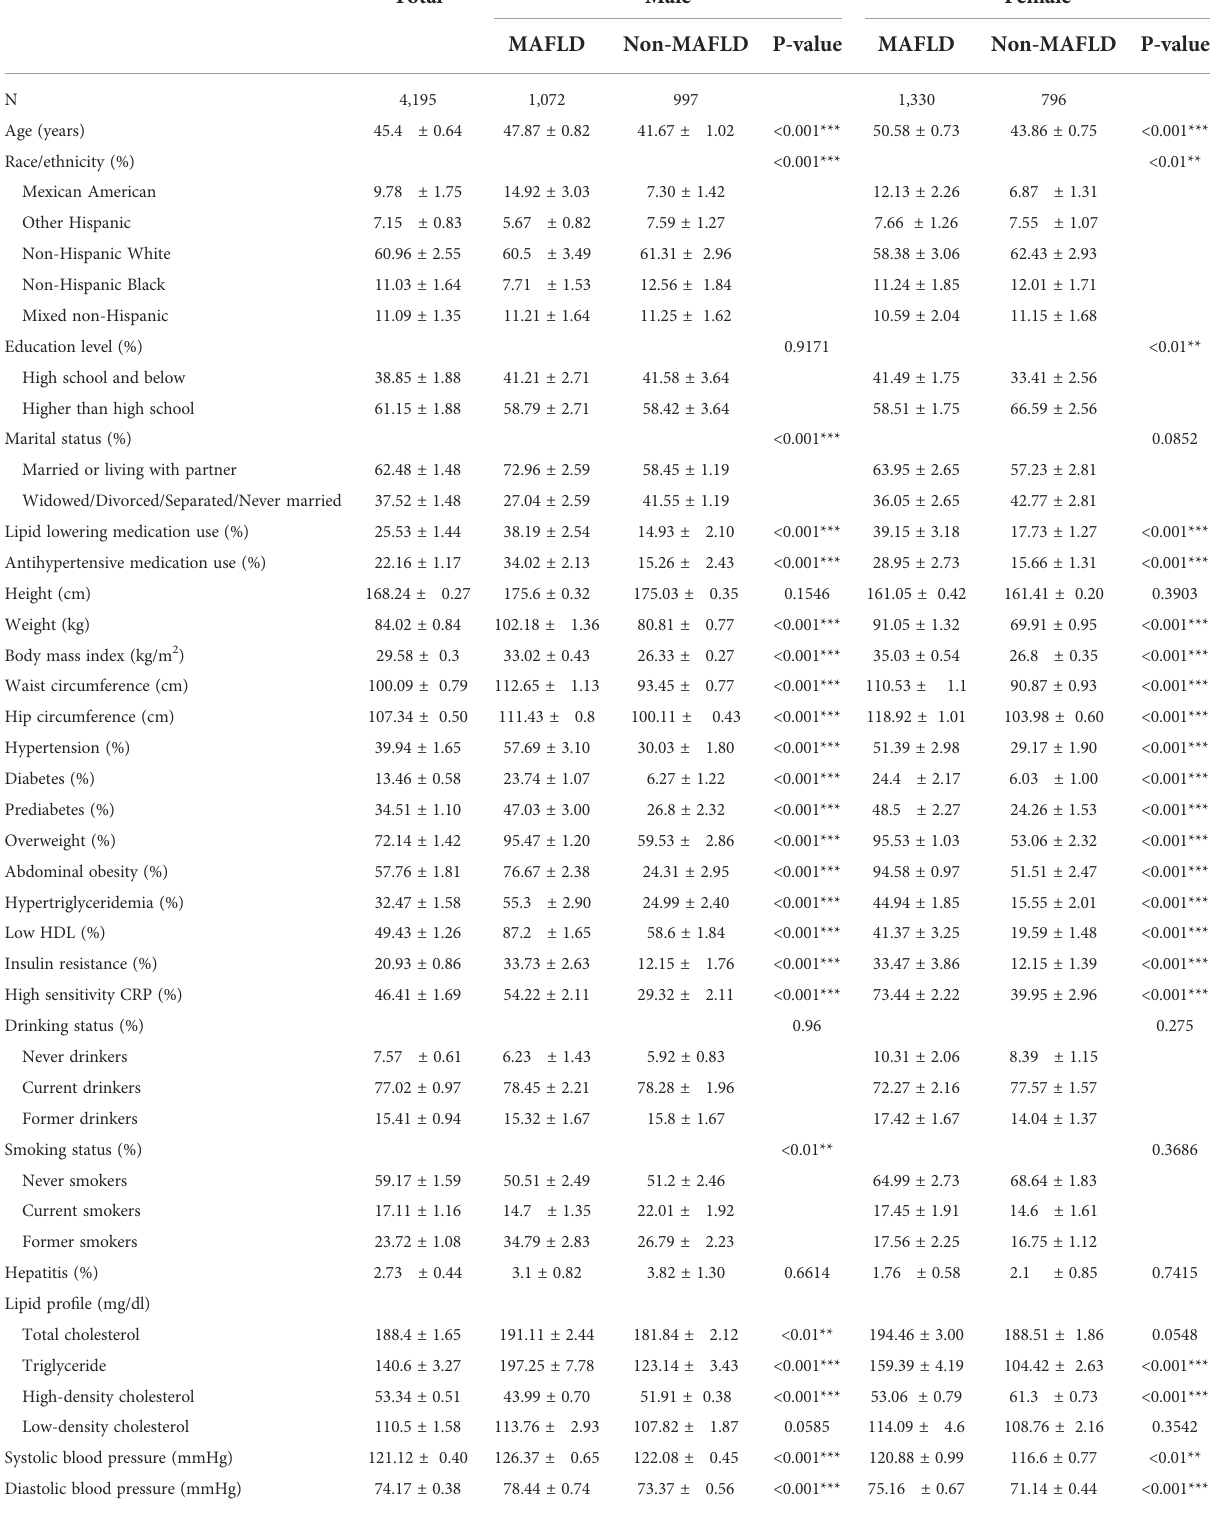
TABLE 1 Clinical characteristics of the study participants classi fi ed by the presence of different gender and metabolic dysfunction-associated fatty liver disease